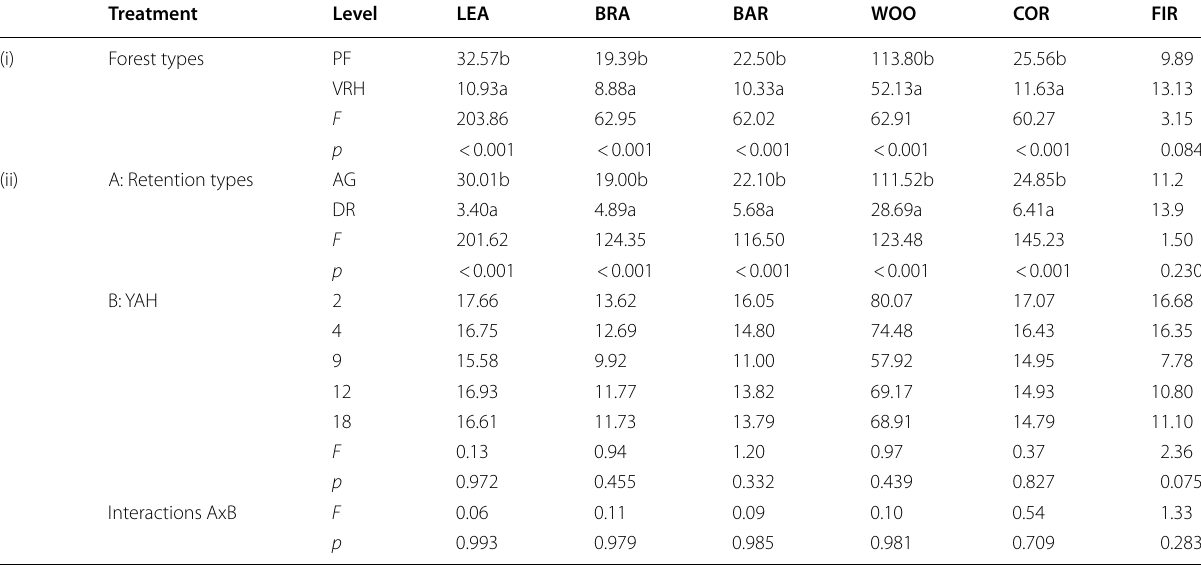
Table 4 Comparisons for carbon content (t C ha − 1 ) of the different components of trees category (see Table 1): (i) simple ANOVAs considering primary unmanaged forests (PF) and stands under variable retention harvesting (VRH), and (ii) multiple ANOVAs considering different retention types in harvested stands (AG: aggregated retention; DR: dispersed retention) and years after harvesting (YAH) as main